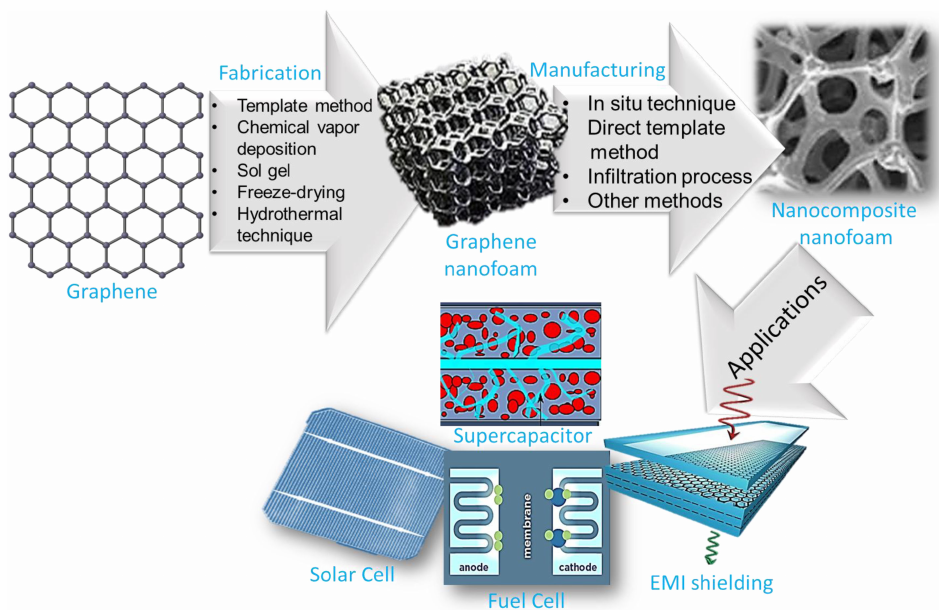
Figure 1. Schematic of technological developments of graphene-to-graphene nanofoam and nanocom- posite